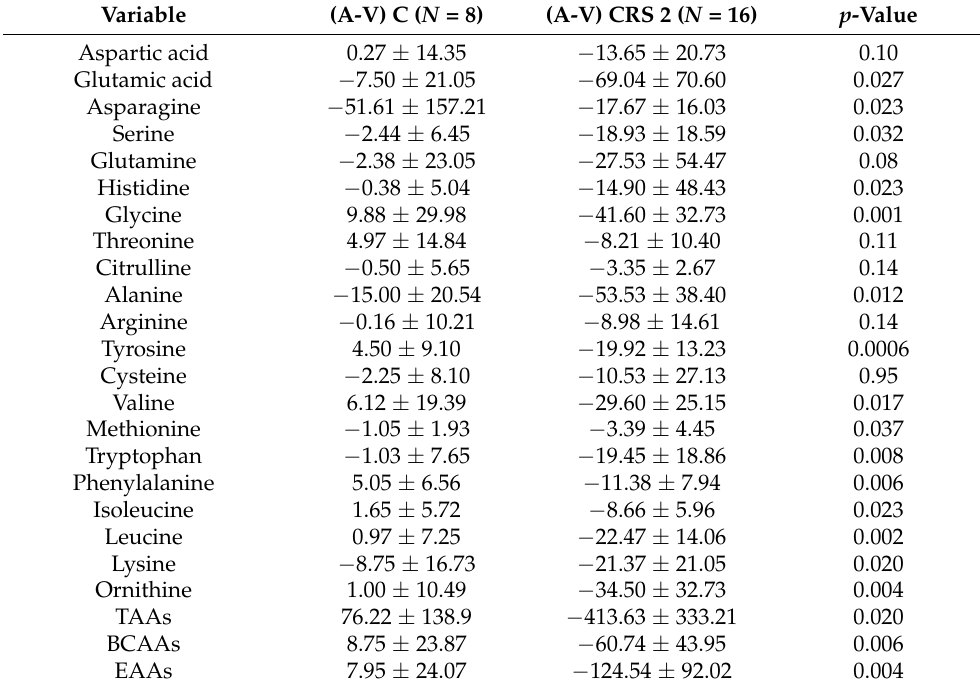
Data are given as mean ± SD. Reported p -values are from Mann–Whitney U-test. AA, amino acid; C, controls; CRS 2, cardiorenal syndrome type 2; TAAs, total amino acids; BCAAs, branched chain amino acids; EAAs, essential amino acids. Table 4. (A-V) AA differences ( µ mol/L) in controls (C) and cardiorenal syndrome type 2 (CRS 2)